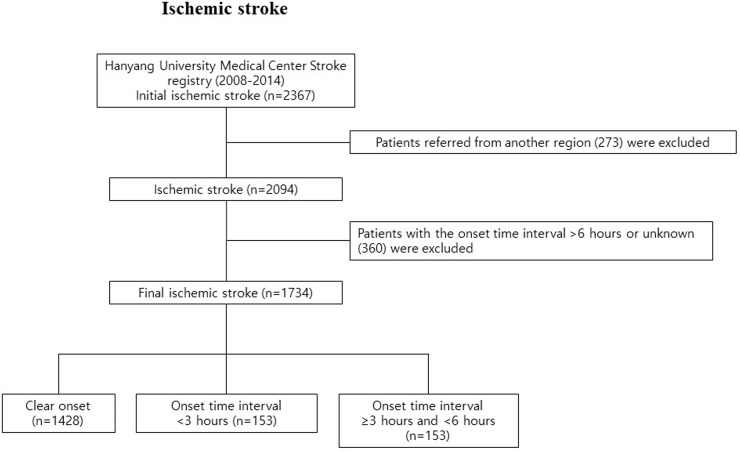
Flow chart of the process for selecting eligible patients for our study from the Hanyang University Medical Center Stroke Registry during the period from January 1, 2008, to December 31, 2014.